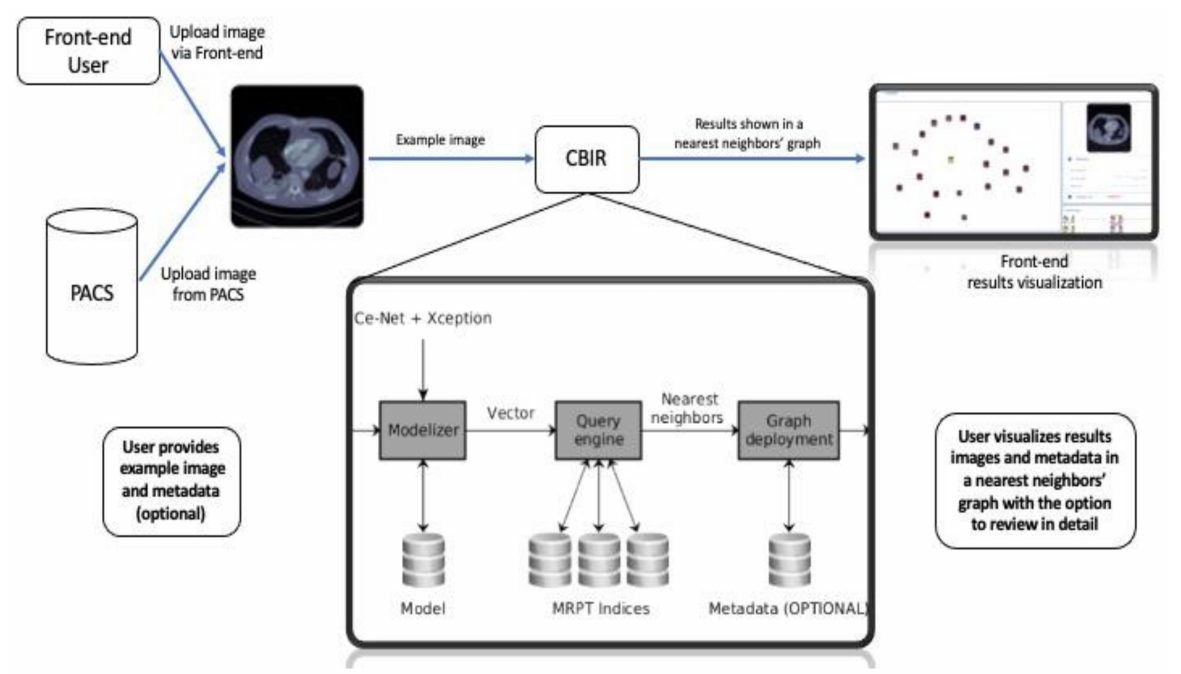
Figure 2. Pipeline of the proposed system. A query image is provided via the front-end or sent directly from the institution’s PACS. The system has a query pipeline on the front-end of the intelligent interactive visual browser for medical images. A new image is processed using the CE-Net + Xception architectures to obtain its vectorized latent representation. The query engine accesses the repository indexes, retrieving the nearest neighbors images from the repository, which are displayed by the interactive visual browser for medical images (as shown further in Figure 3). Metadata, whenever available, is also displayed. Then, the nearest neighbors’ graph is shown in the front-end to visualize the results.